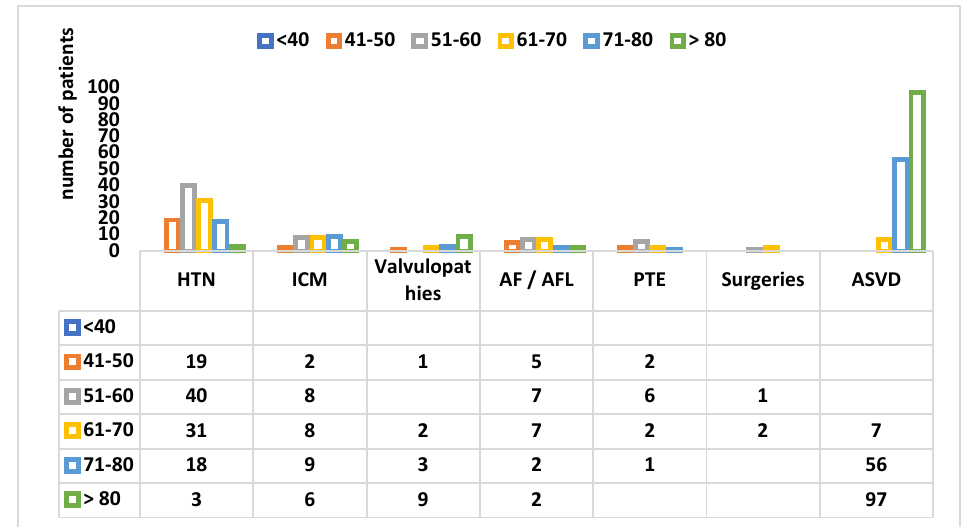
Figure 8. The distribution of cardiac diseases by age group in patients from COV-2 BATCH. HTN—arterial hypertension, ICM—ischemic cardiomyopathy, Afib—atrial fibrillation, AFL—atrial flutter, PTE—pulmonary thromboembolism, ASVD—arteriosclerotic vascular disease.